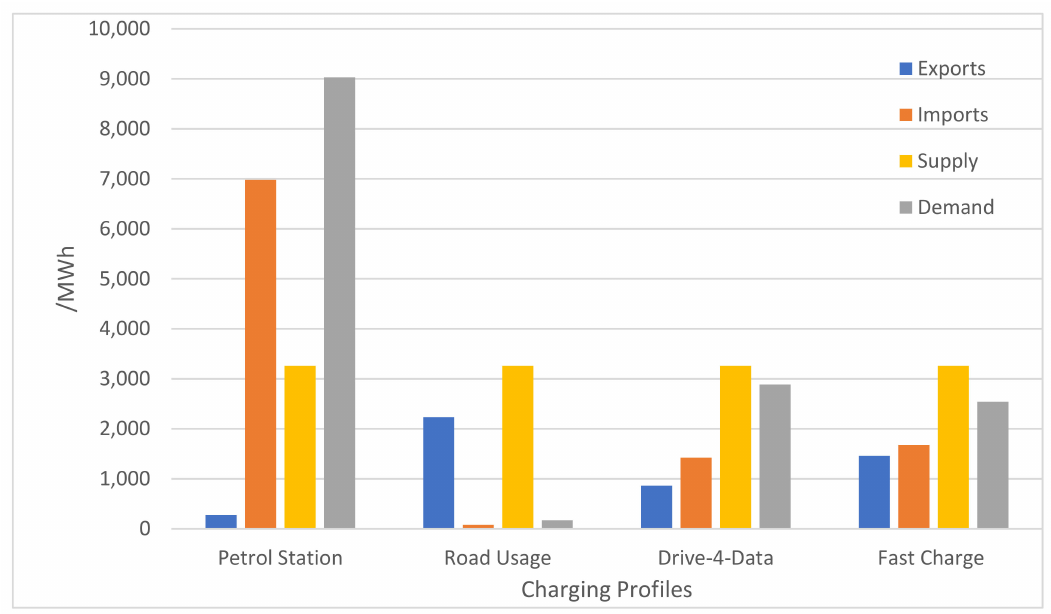
Figure 10. The annual power supply and demand and energy imports and exports of the grid-connected system with no storage as a function of the charging